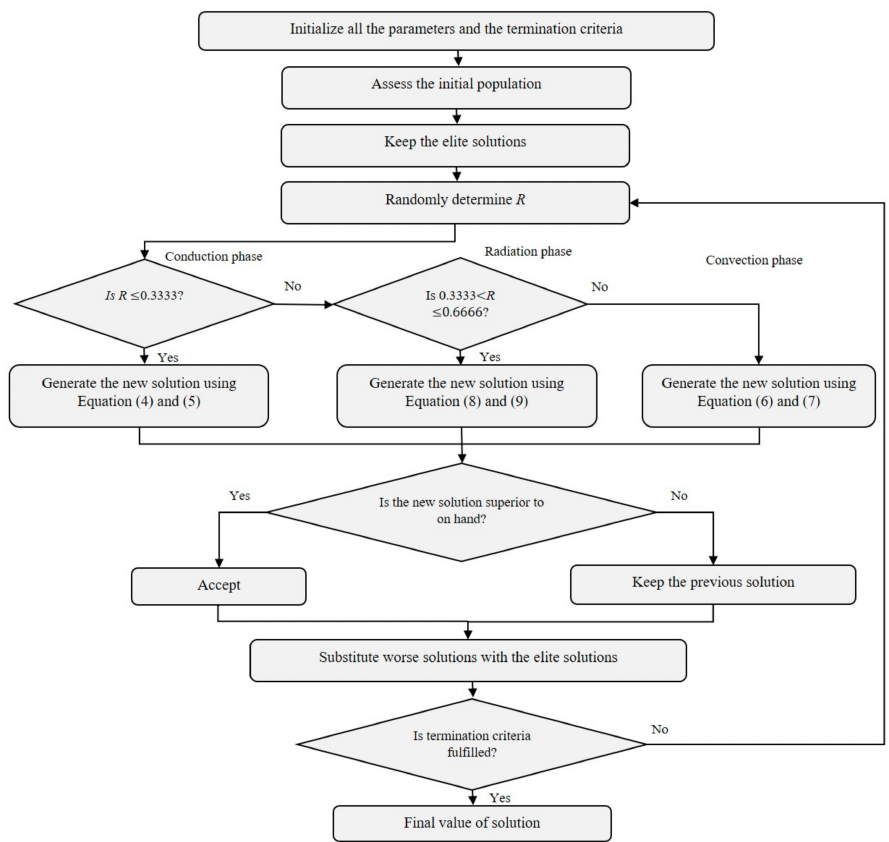
Figure 1. The overall flowchart of the HTS